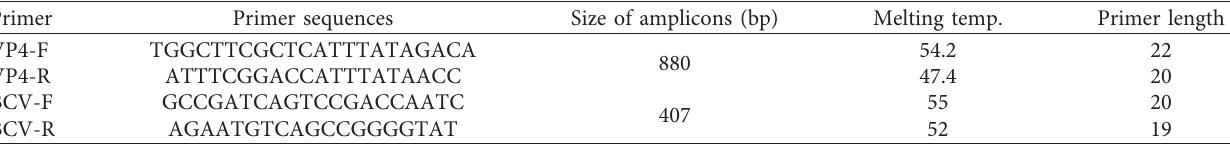
Table 1: Primer details.